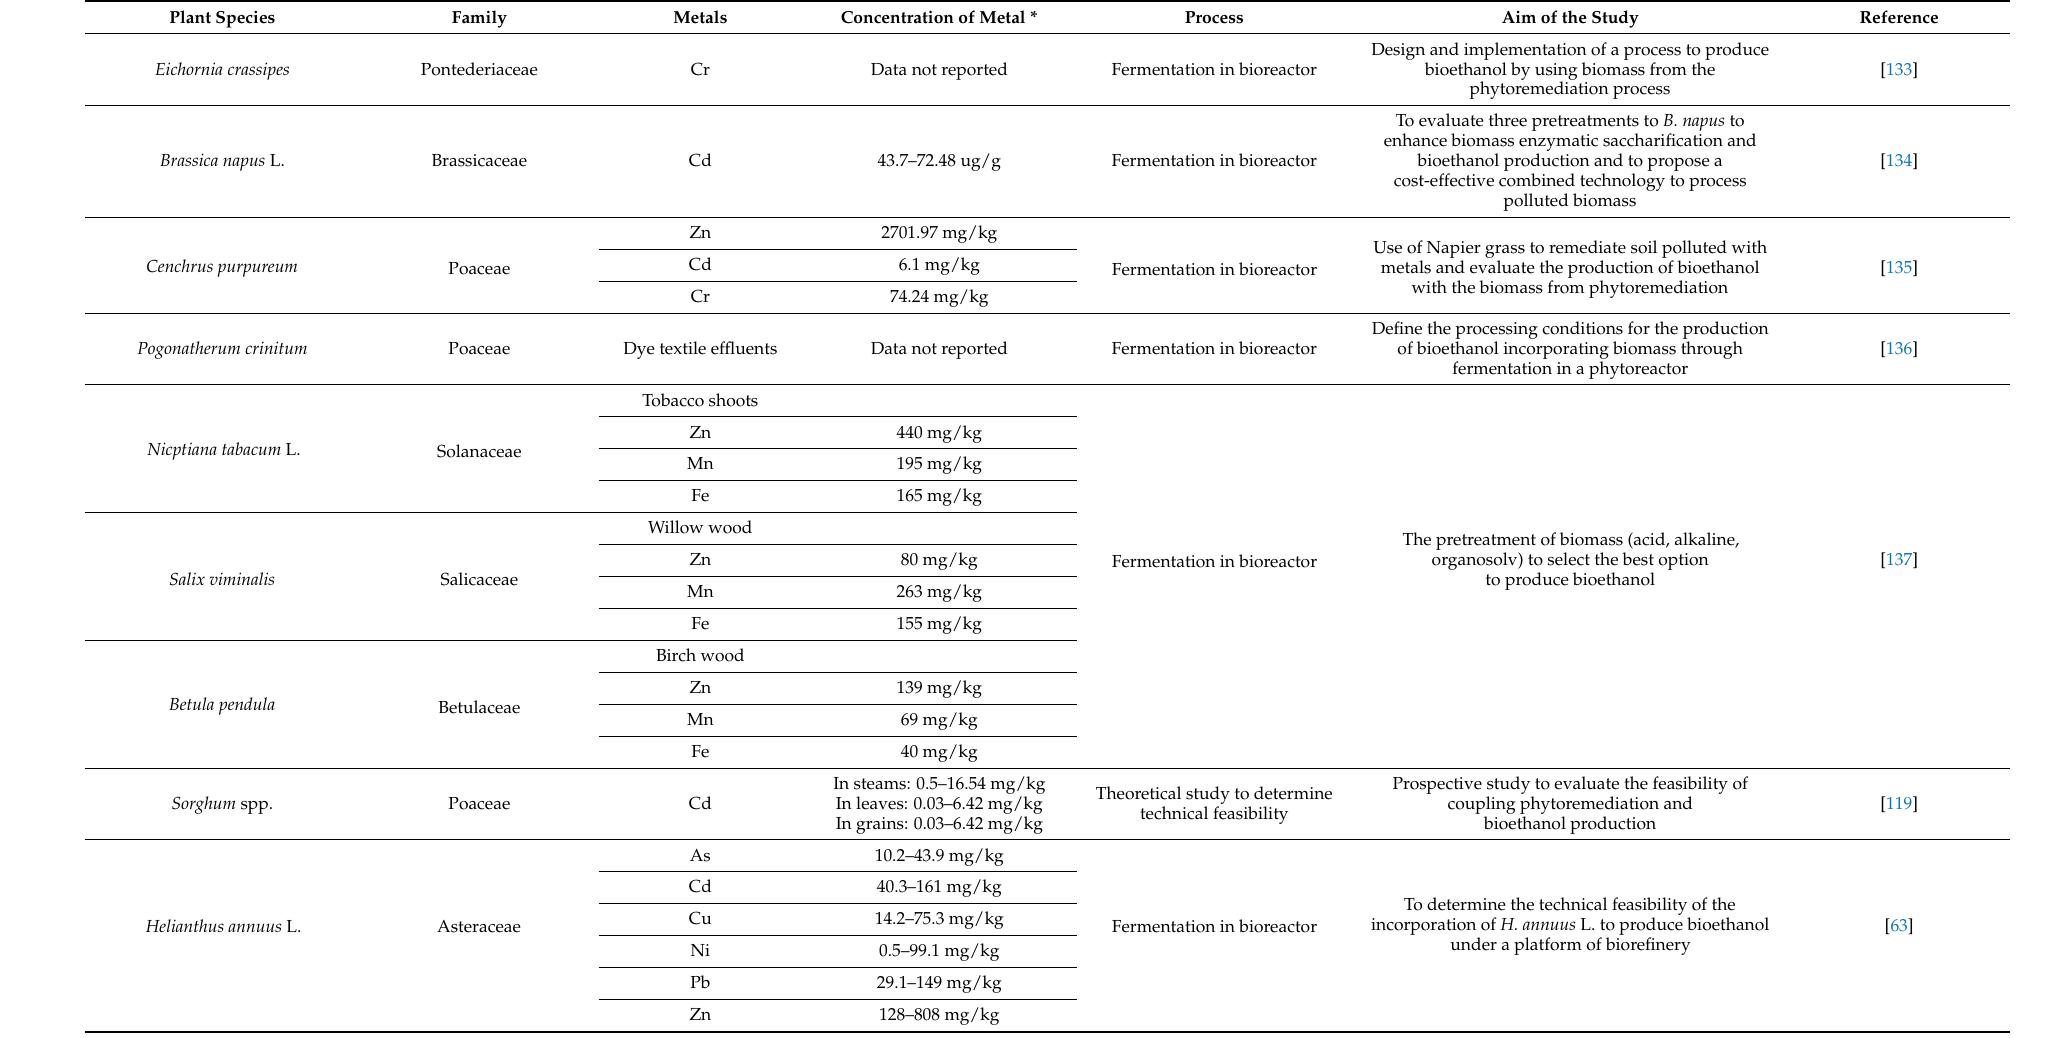
Table 4. Use of phytoremediation biomass to produce liquid